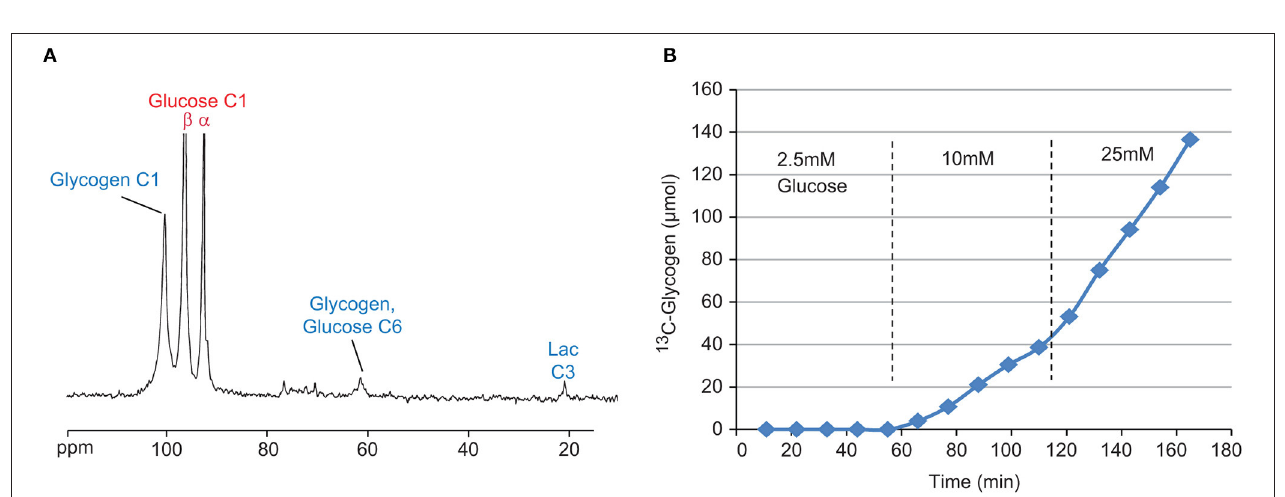
FIGURE 2 | Essential components of the perfused liver apparatus.